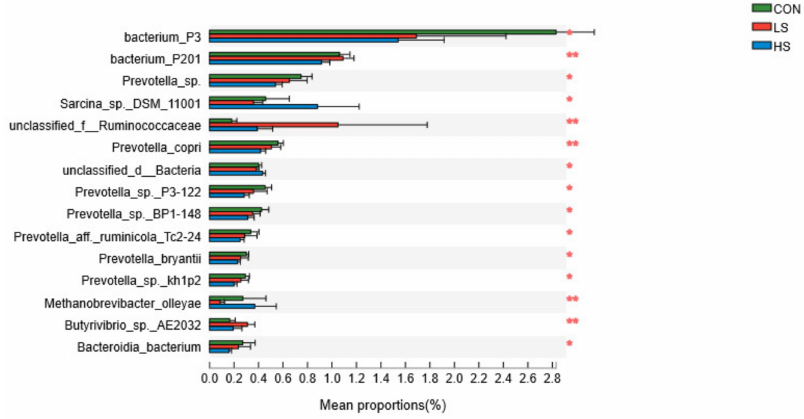
Figure 4. Effect of selenium yeast on rumen dominant bacteria at species level (>1%; as a percentage of the total sequence). CON = basal diet; LS = basal diet + 2.4 mg/kg SY; HS = basal diet + 4.8 mg/kg SY. * p < 0.05, ** p <